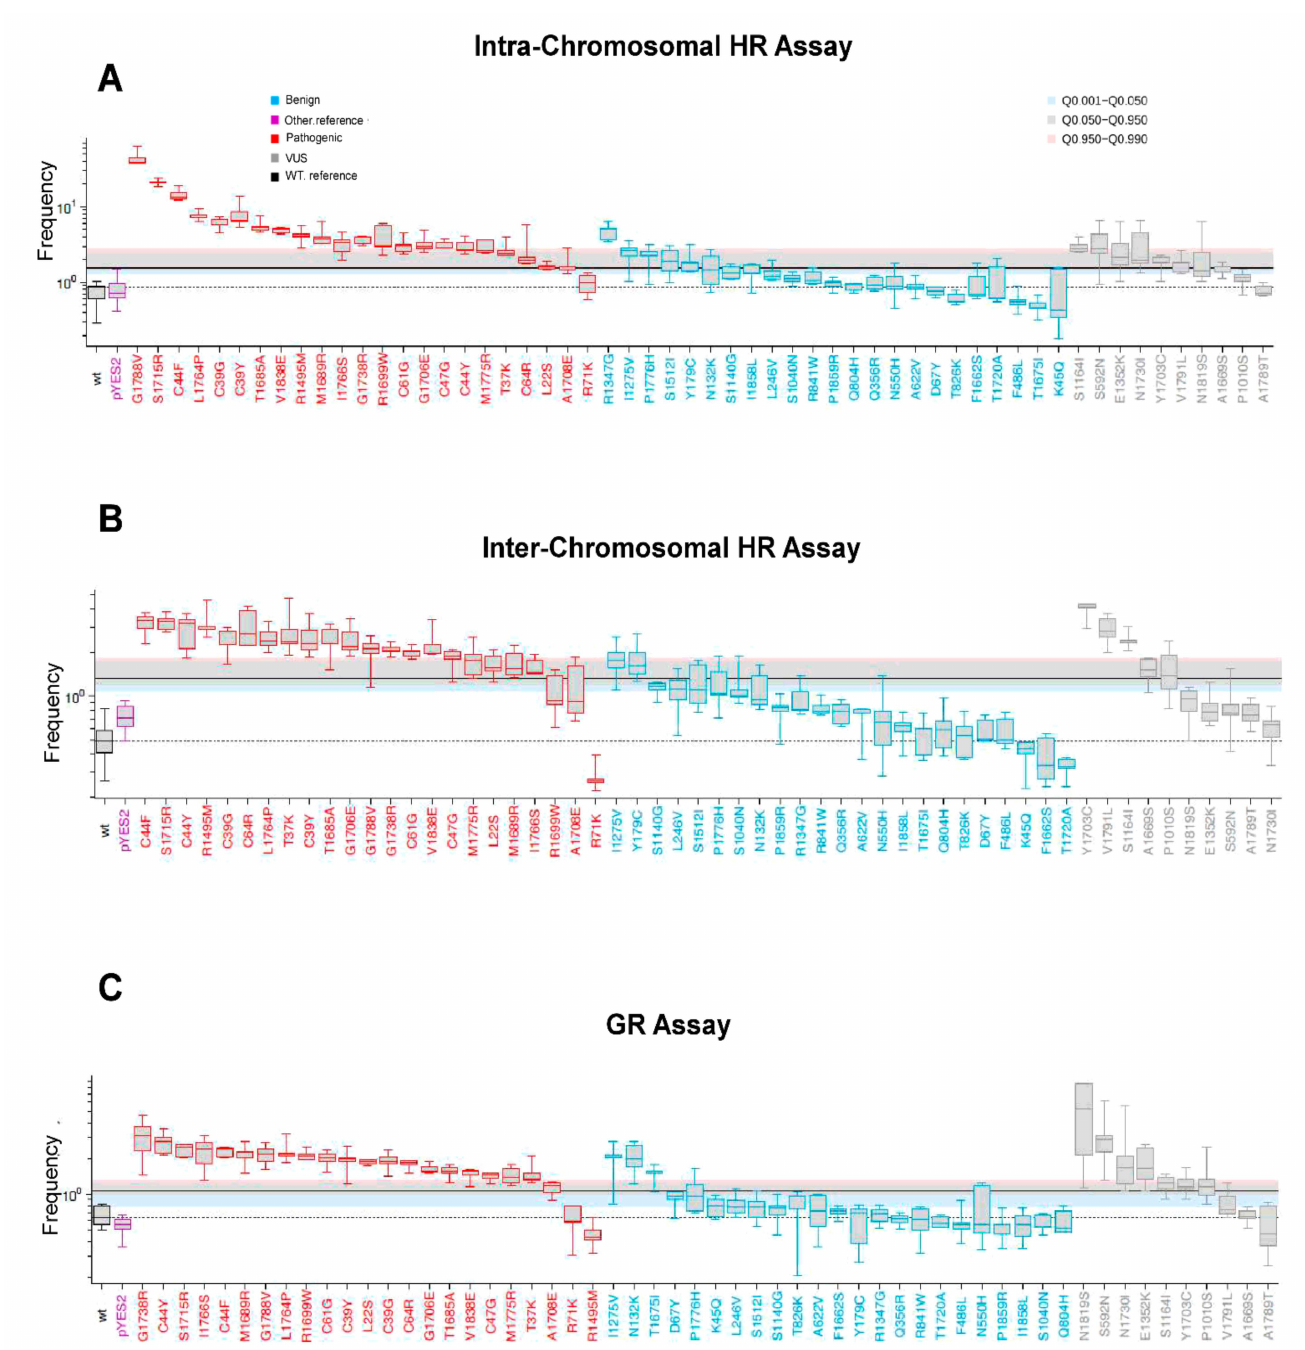
Figure 3. Waterfall distribution of pathogenic and benign variants and positions of best cut-offs. The data are reported as box-and-whisker plots; red, blue, and grey box indicate pathogenic, benign, and VUS, respectively. The central bar of the data box represents the median of 5–15 independent experiments; the box indicates the interquartile range (50% of data distribution), and the whiskers show the extreme values. The horizontal dotted line represents the median of control (BRCA1 wild- type). The thick line is the best cut-off; pink, grey, and light blue areas define 4%, 90%, and 4.9% of total distribution. These parameters are determined by the ProClass (http://xfer.curie.fr/get/ tvsjyy4dUno/ProClass_toolbox.zip, accessed on 12 January 2022) toolbox. ( A ) Waterfall distribution of intra-chromosomal HR, ( B ) inter-chromosomal HR, and ( C ) gene reversion